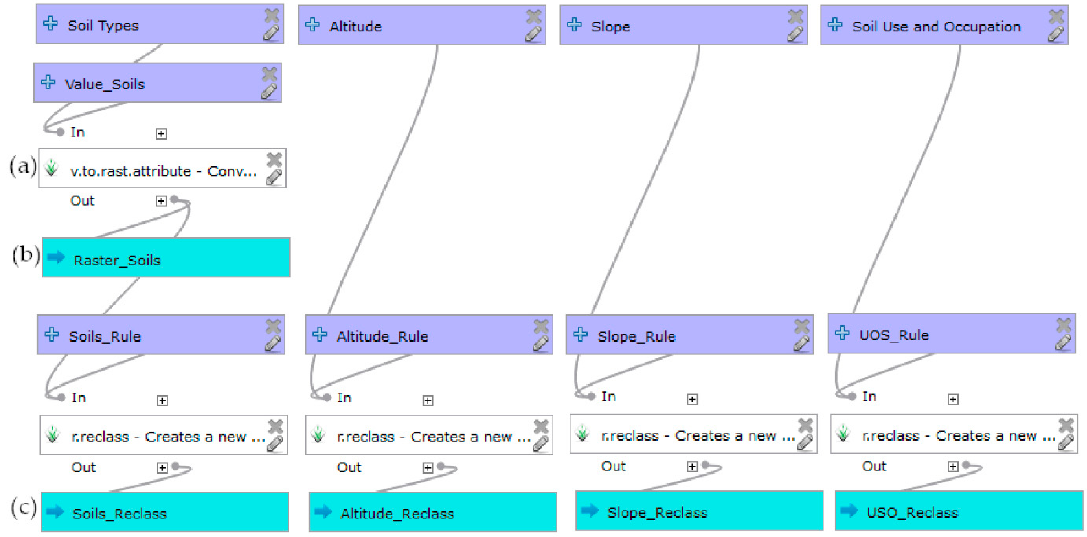
Figure 3. Construction of the variable reclassification model (VRM) in QGIS consisted of: ( a ) converting the different soil types from vector format to raster format; ( b ) inserting the rules in accordance with the scores established for each factor; and ( c ) reclassifying each raster using the r.reclass algorithm.